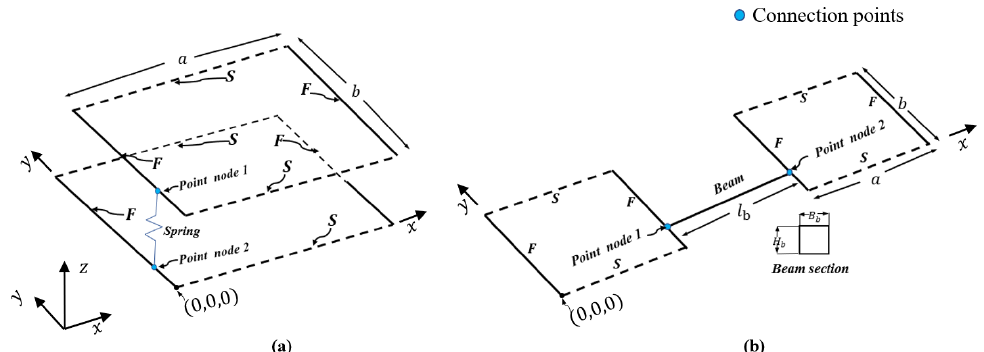
Figure 17. Two plates coupled by a spring ( a ) or a beam ( b ) structure.